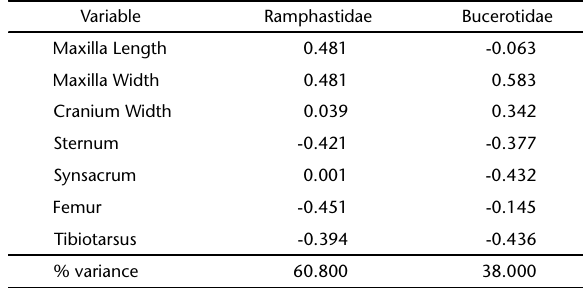
Table II. Variable loadings on the principal components (PC1) derived from transformed skeletal measurements of 21 species of Ramphastidae and 24 species of